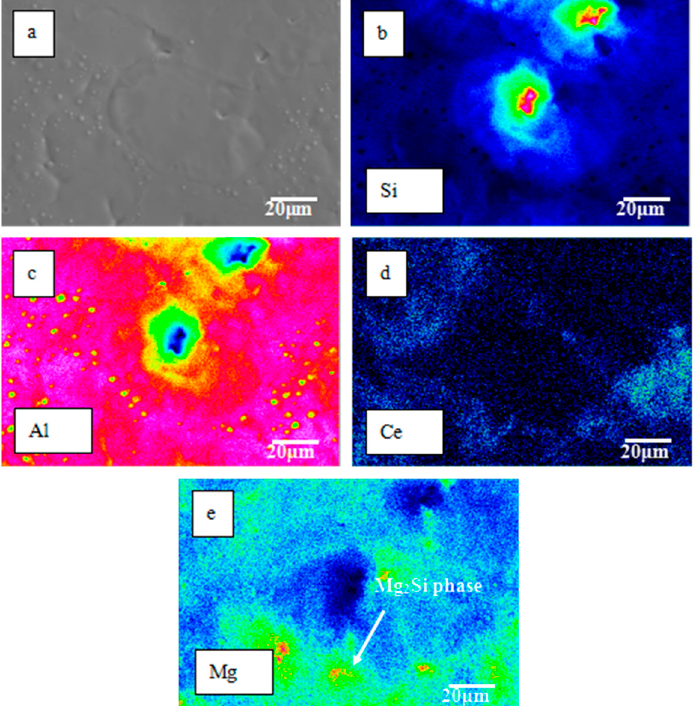
Figure 6. EPMA images of the 25-pulse treated Al–20Si–5Mg–0.7Ce alloy surface. ( a ) SE image; ( b ) elemental profile of Si; ( c ) elemental profile of Al; ( d ) elemental profile of Ce; ( e ) elemental profile of Mg.